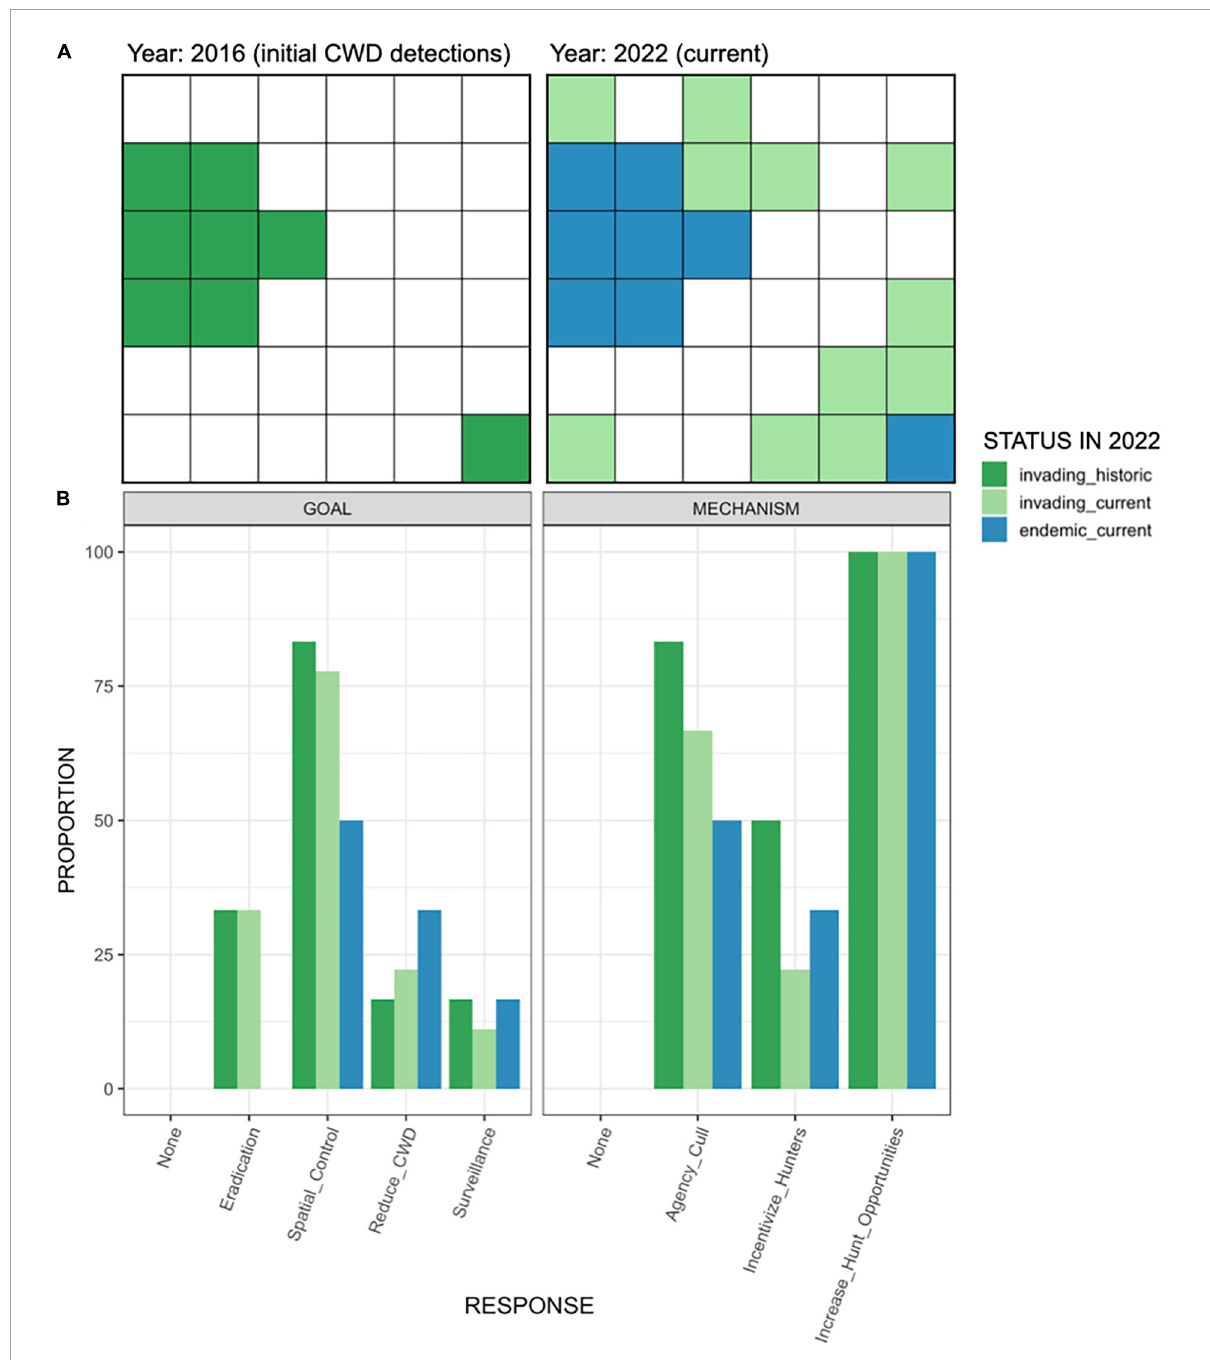
FIGURE4 (A) Hypothetical example of chronic wasting disease (CWD) status classifications of deer management units (grid squares) in a state (larger 6 × 6 square) from 2016 when CWD was first detected in the state to the current year 2022. CWD status across the state is partitioned by CWD presence: invading (CWD present for < 5 years, green shades), endemic (CWD present for ≥ 5 years, dark blue), and undetected (white). CWD status is also partitioned by time: current (light green, dark blue) and historic (dark green). (B) The proportion of state agency responses to CWD in terms of management goals (left panel) and management mechanisms (right panel) based on current CWD status (endemic, currently invading, historically invading). To compare CWD responses through time in the same area, compare the dark green to dark blue responses [shown in panel (A) ]; to compare how responses to CWD invasion have changed, compare the dark green to light green responses [shown in panel (A) ]. Management goals include: none, eradication, spatial control, generally reduce CWD prevalence, and implementation of/increased surveillance. Management mechanisms include: none, agency-regulated/sponsored culls/removals, incentivizing or requiring hunters to kill more deer, and increasing hunting